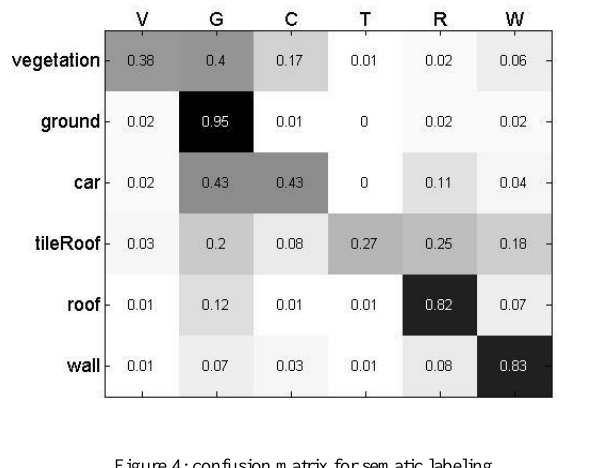
Figure 4: confusion matrix for sematic labeling